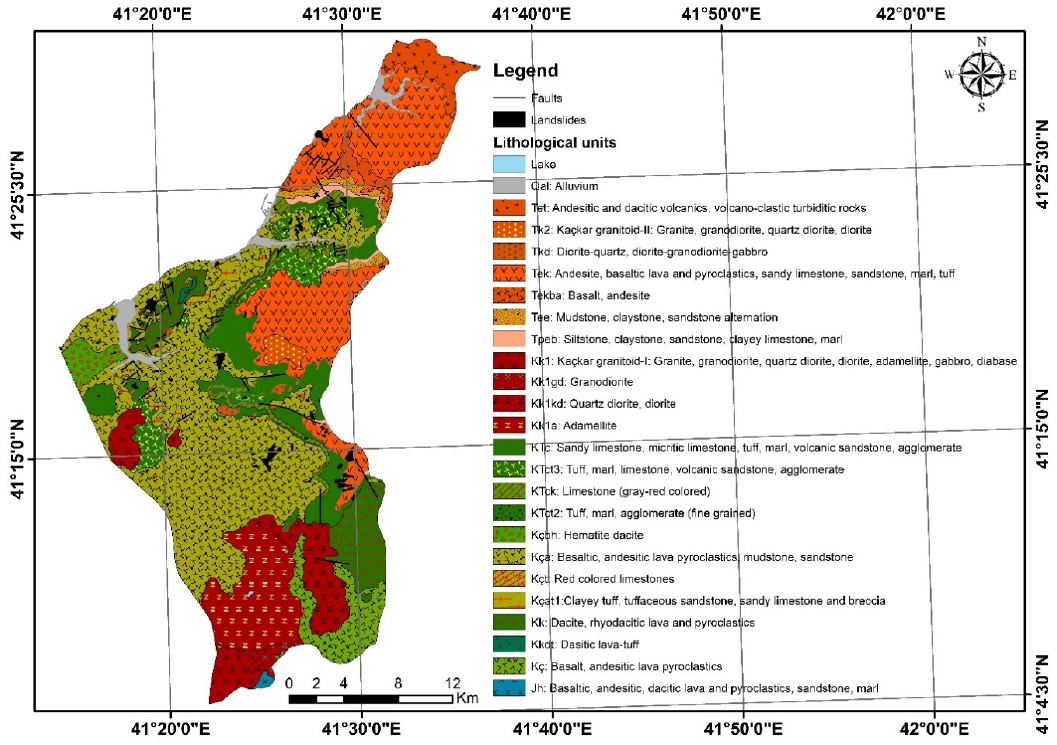
Figure 4. Geological map of the study area [59,81].